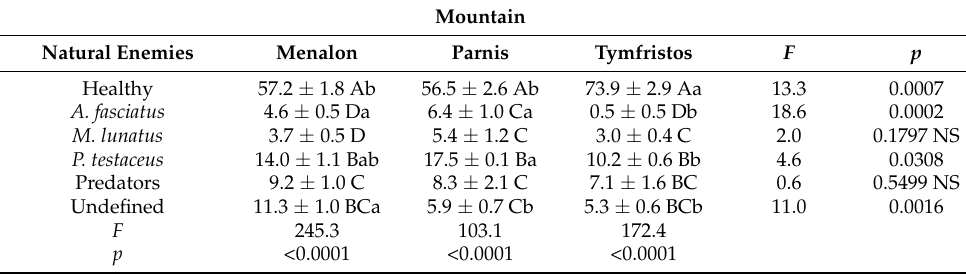
Table 5. Mean values ( ± SE) of the activity of natural enemies [E (%) ] of P. hellenicus in three mountains of Greece.